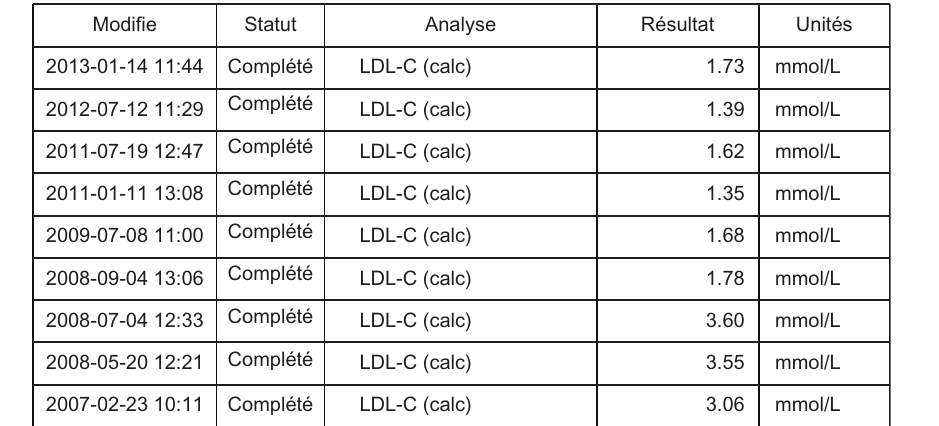
Figure 2. A real-world document extracted from the data fi le of a patient randomized in